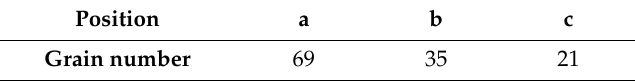
Figure 5. Diagrams and inverse pole figure at different heights with width 10 mm. ( a ) Height 2 mm; ( b ) Height 15 mm; and ( c ) Height 25 mm. Table 3. Grain numbers at different heights of grain selector.